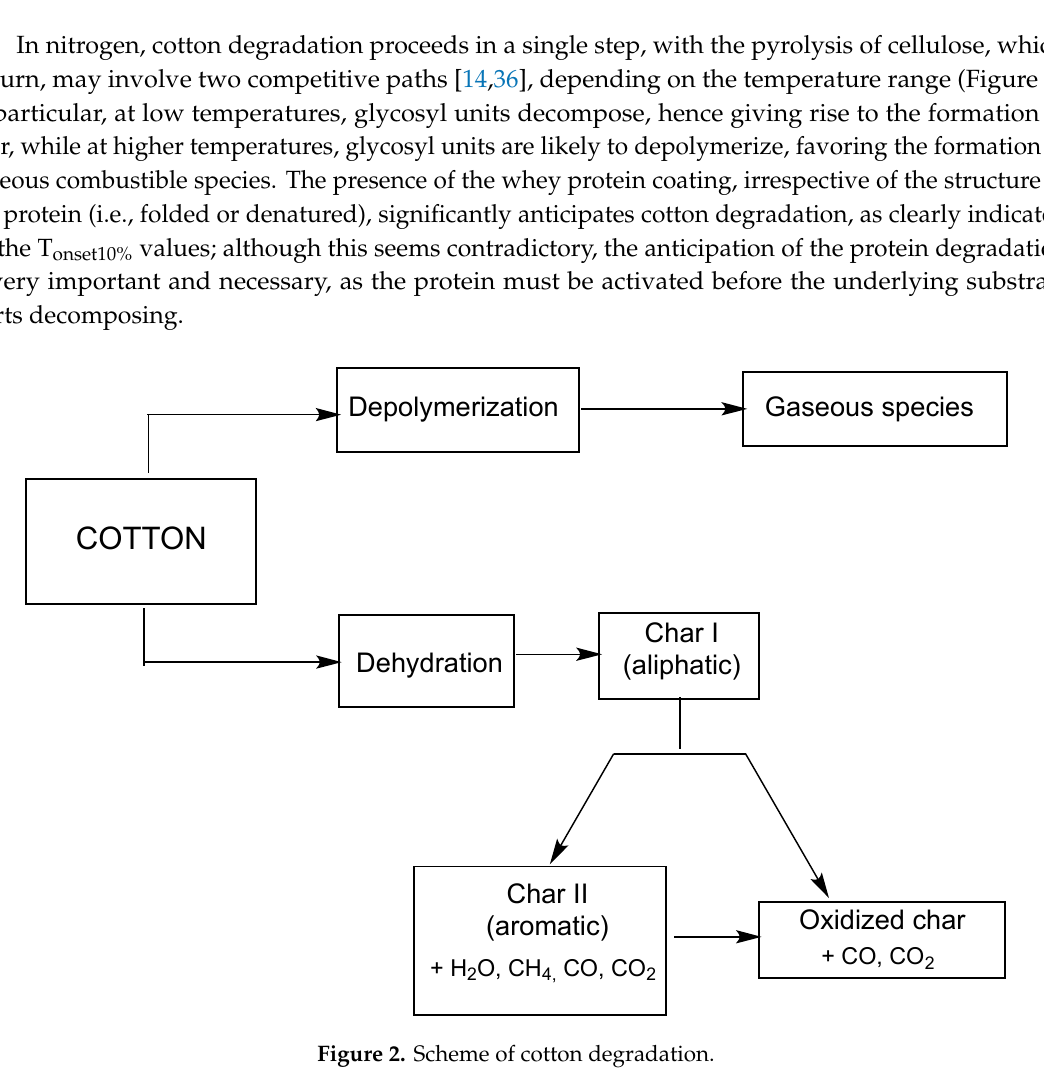
Table 2. Horizontal flame spread data for untreated and treated cotton fabrics.